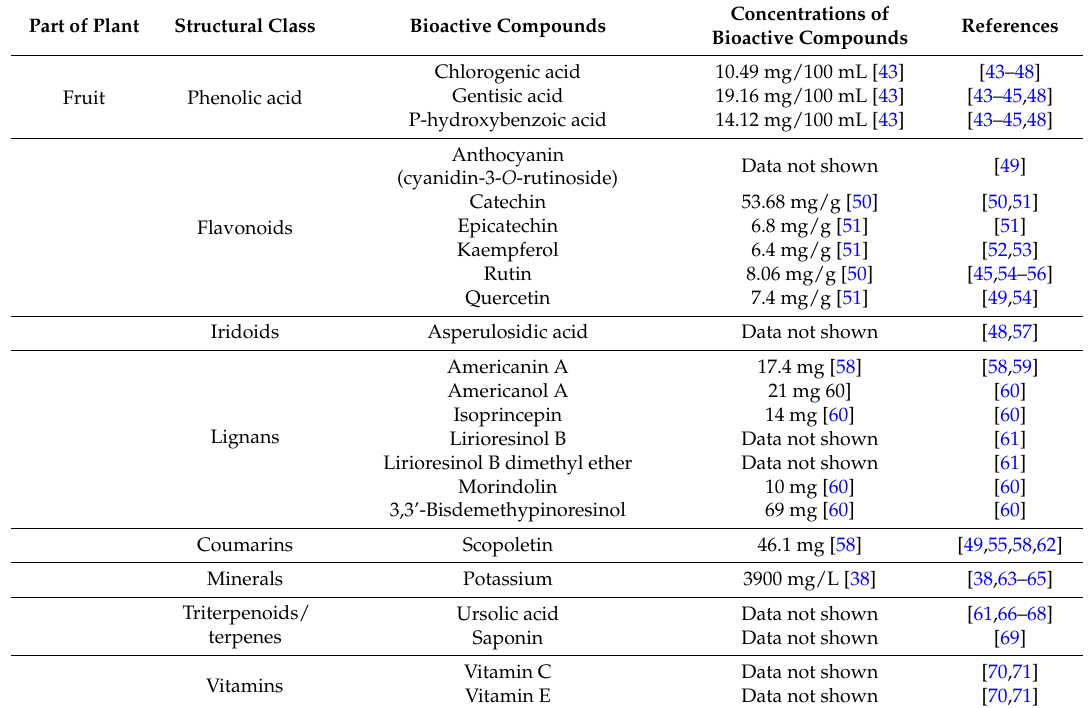
Table 1. Principal phytochemicals from Morinda citrifolia as bioactive compounds against obesity and obesity-related metabolic